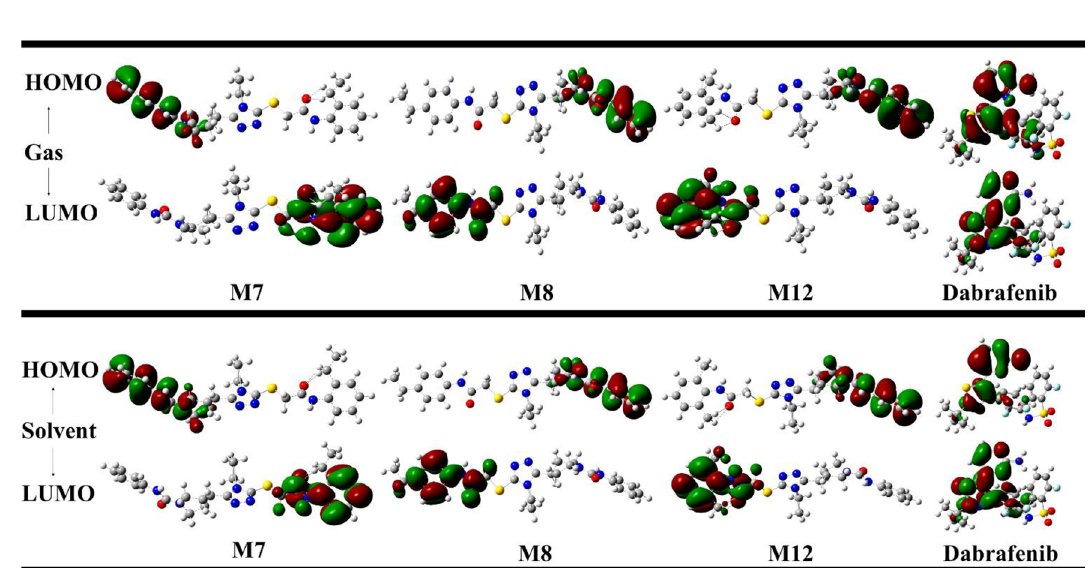
Figure 4. Calculated HOMO and LUMO orbitals of potent derivatives at B3LYP/SVP level of DFT